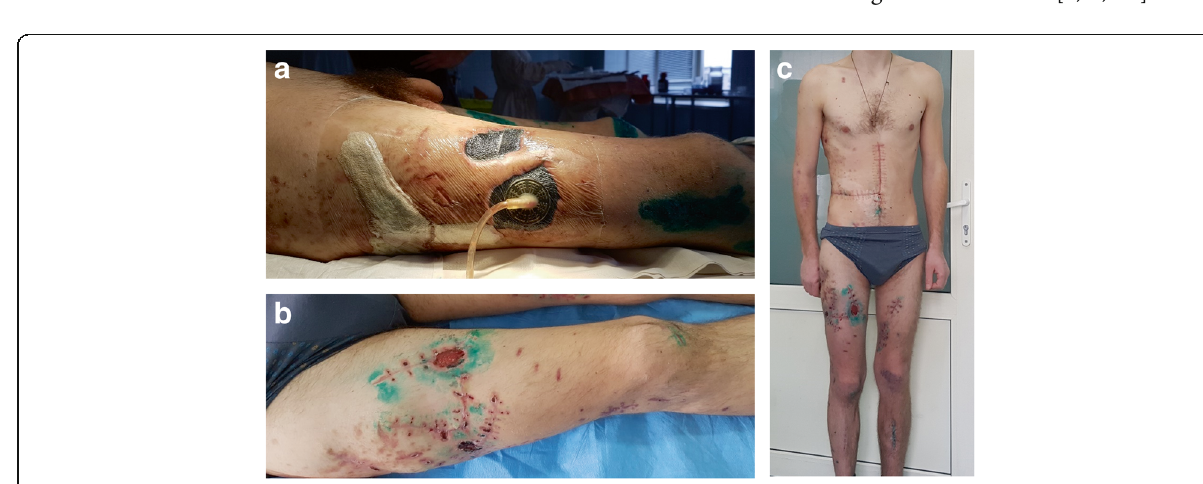
Fig. 6 Photograph illustrating the damages of soft tissues after multiple-launch rocket system “ Grad ” . a The shrapnel wounds lateral area of the right thigh with installing of VAC system on the 21st day after the injury. b The shrapnel wounds at the anterior area of the right thigh on the 49th day after the injury. c The overall look of the patient with post-operative and post-injury scars before discharge from the hospital on the 49th day after